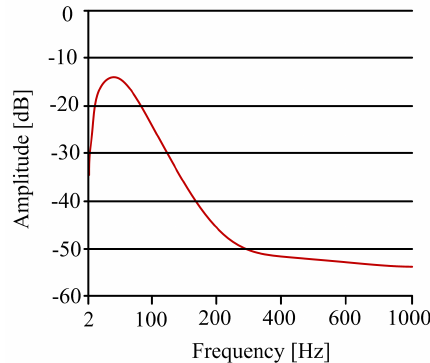
Figure 5. Frequency characteristic of the interferometric sensor.